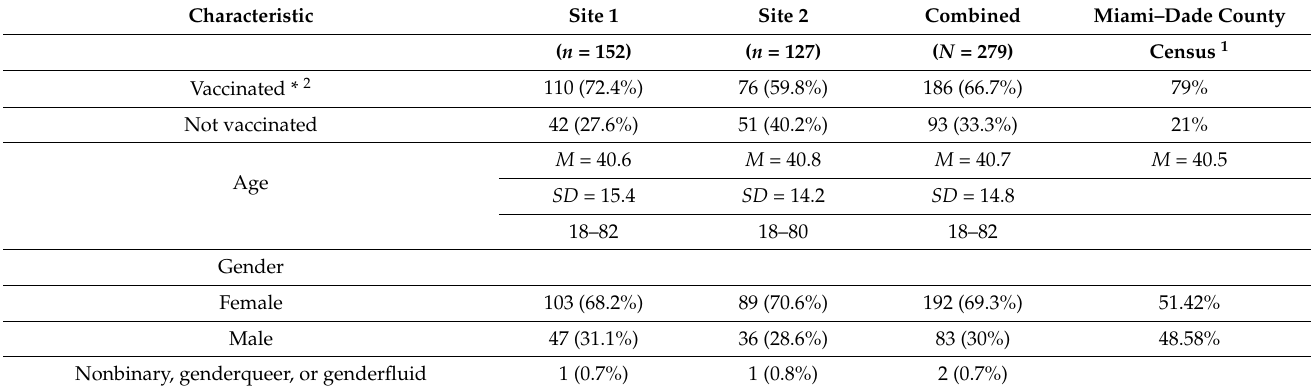
Table 1. Demographic Characteristics of Survey Respondents: overall, by source, and compared to census